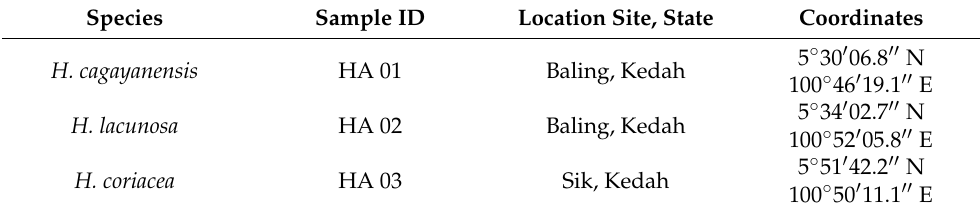
Table 1. List of flower species and collection locality. Species Sample ID Location Site, State